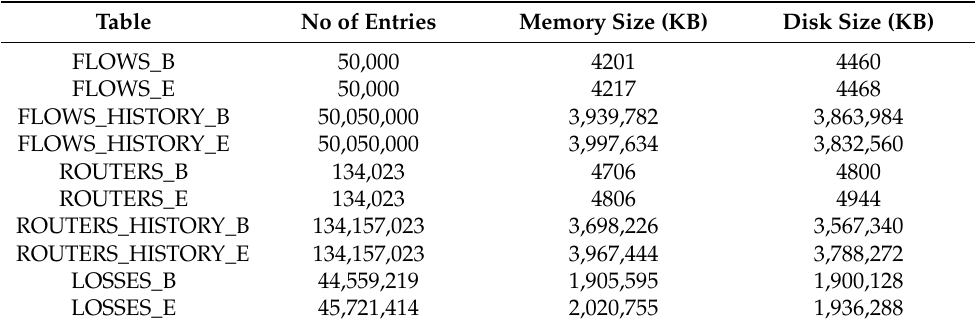
Table 2. Comparison of the number of rows, memory, and disk size for the basic (B) and energy-saving (E) models.